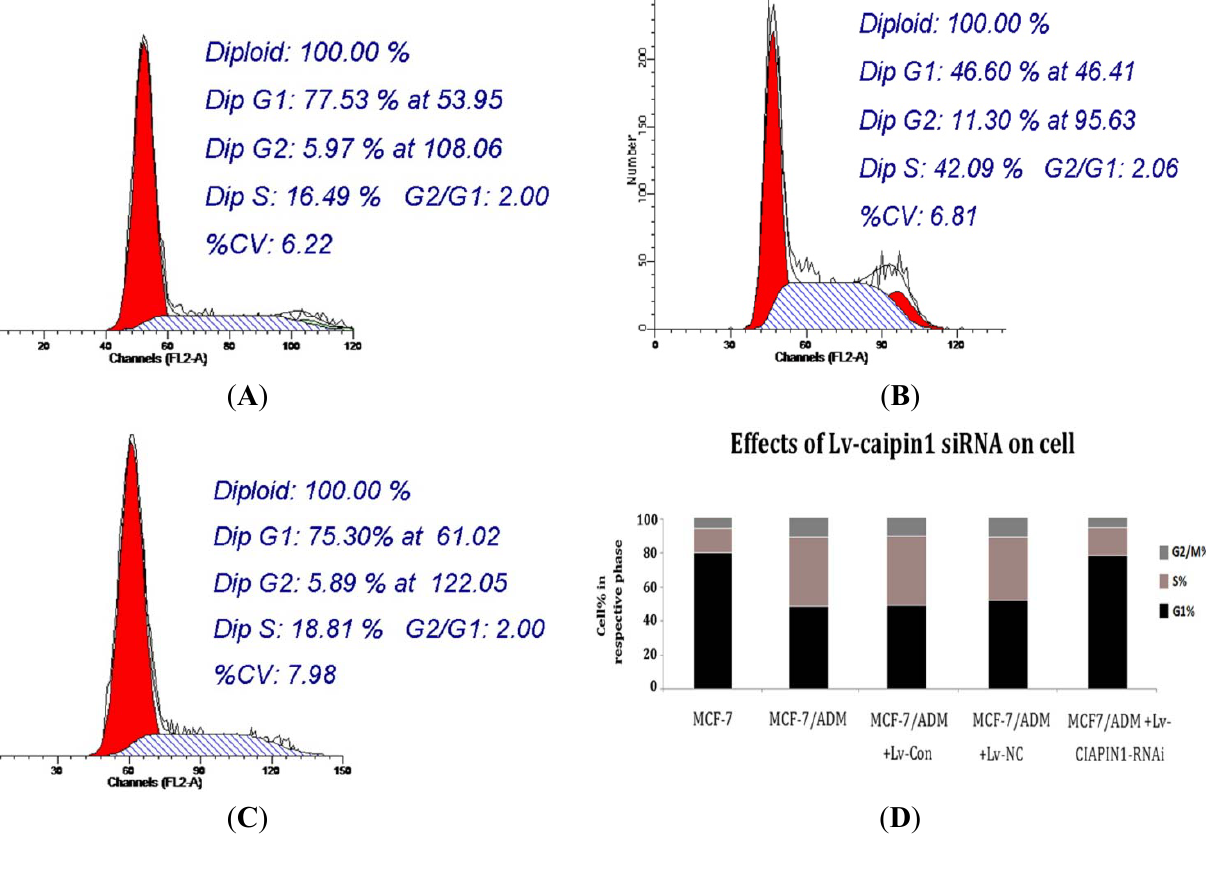
Figure 8. Results from flow cytometry analysis showed that the cell cycle distribution was significantly affected by siRNA targeting CIAPIN1. ( A ): MCF7; ( B ): MCF7/ADM before RNAi; ( C ): MCF7/ADM after RNAi; ( D ): Proportion of cell cycle of various breast cancer cell